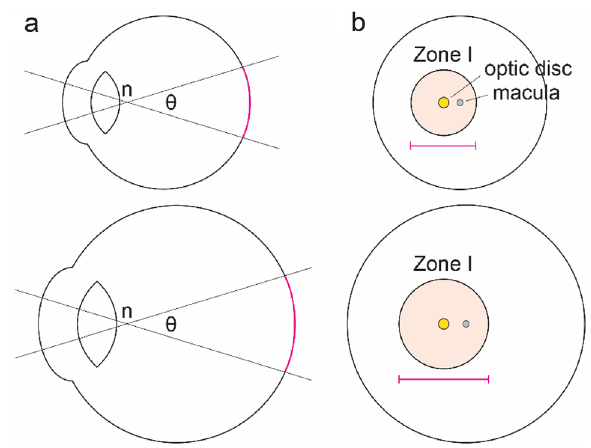
Figure 1. Neonatal eye development in ROP may affect zoning. ( a ) Schematic of a growing eye with the nodal point and nodal angle denoted by n and θ, respectively. As the eye becomes larger and undergoes refractive changes, the area of the region (magenta) encompassed by θ may likewise change. ( b ) Schematic of the retina in a growing eye. Although both regions in beige are defined as Zone I, the absolute areas corresponding to Zone I might differ